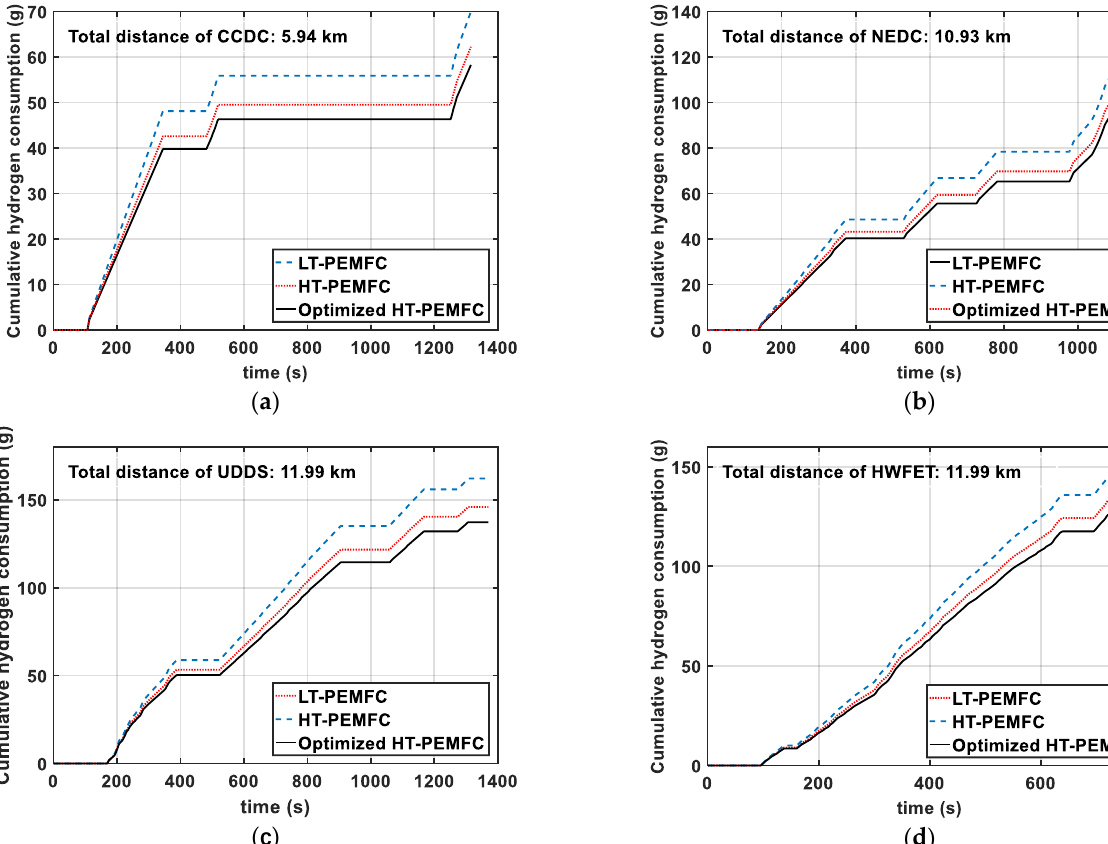
Figure 8. Comparison of fuel cell system efficiency and energy loss: ( a ) Efficiency; ( b ) Energy loss.